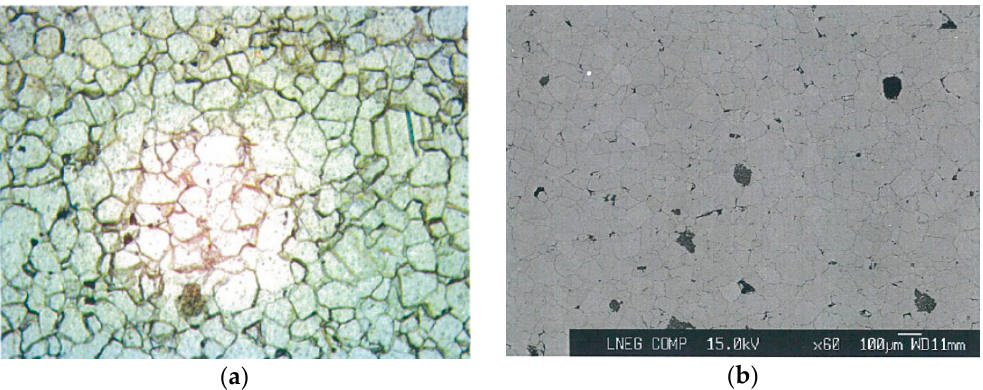
Figure 9. Examples of dynamic modulus of elasticity measurement: ( a ) transversal direction; ( b ) longitudinal direction.